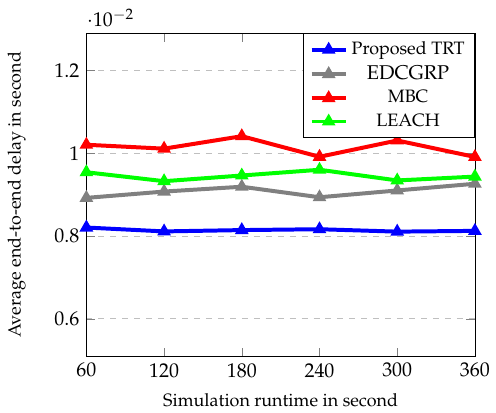
Figure 8. Average end-to-end delay vs. Simulation runtime.